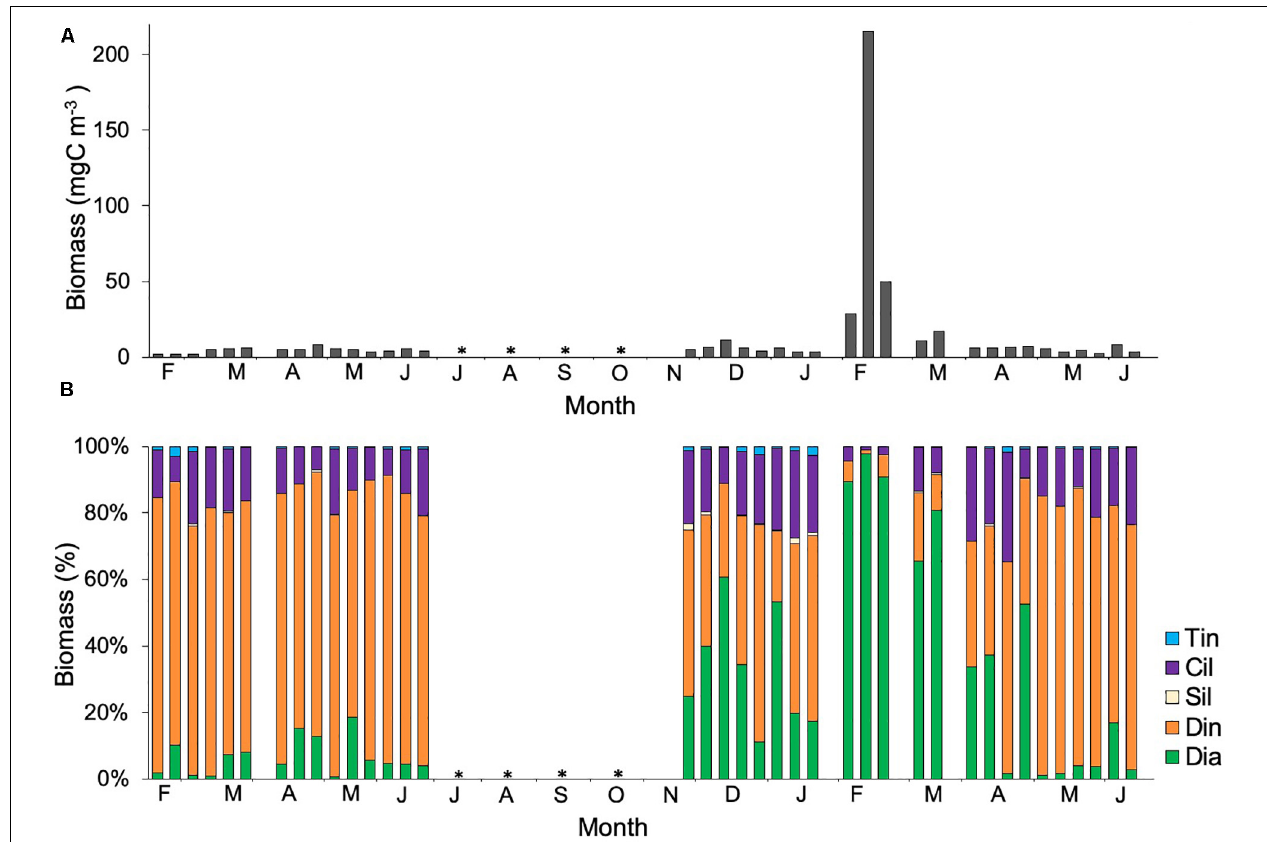
FIGURE 7 | (A) Temporal variability of averages values (mean ± SE) of biomass for stations 1, 2, and 3, and (B) Percentage for diatoms (Dia, (cid:4) ), dinoflagellates (Din, (cid:4) ), silicoflagellates (Sil, (cid:4) ), ciliates (Cil, (cid:4) ) and tintinnids (Tin, (cid:4) ). No data available is represented by an asterisk.